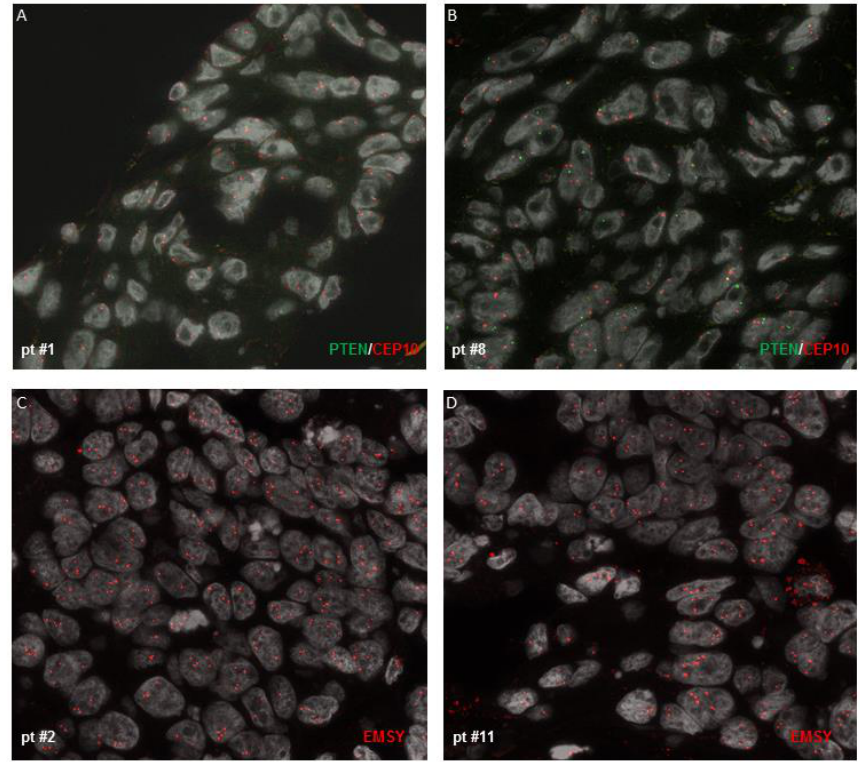
Figure 2. FISH analyses for PTEN and EMSY . PTEN homozygous deletion was observed in patient #1 ( A ) and in patient #8 ( B ). An elevated EMSY copy number was observed in patient #2 ( C ) and in patient #11 ( D ).